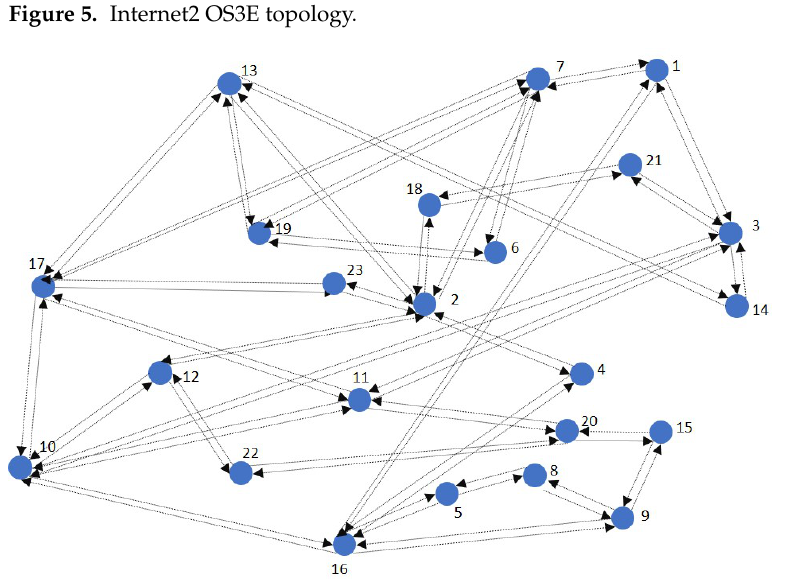
Figure 6. EU-GÉANT topology.